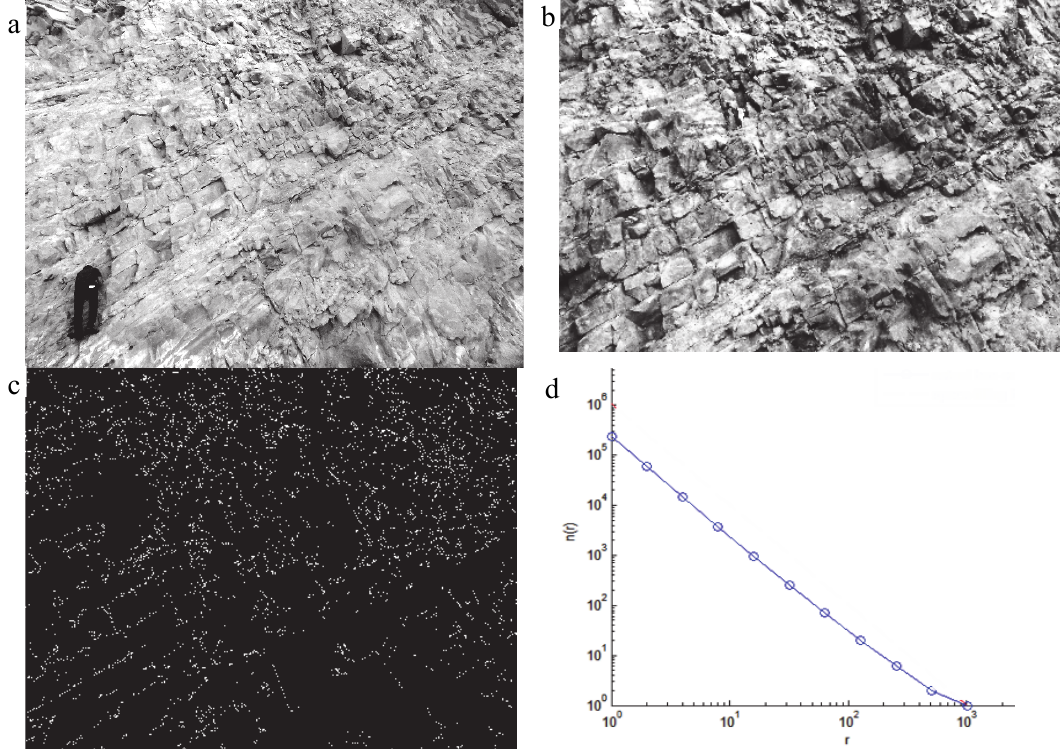
Figure 5: Calculation of fractal dimension using image processing technique: a) converting the color image to gray-scale, b) preprocessing the digital image using Histogram equalization method, c) edge detection using the Canny algorithm, and d) calculation fractal